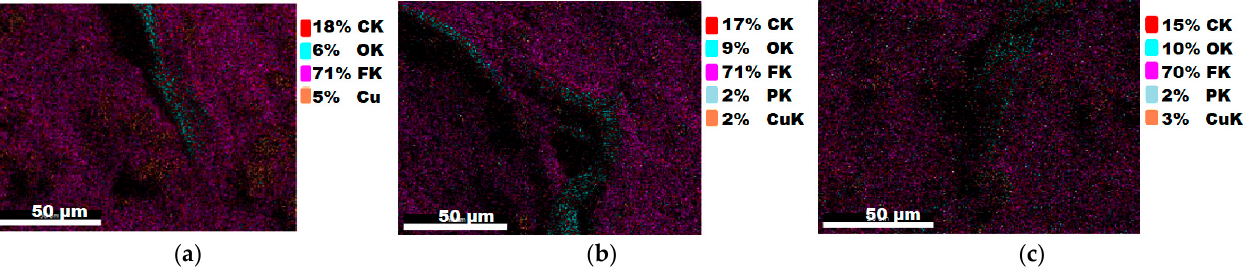
Figure 11. Smart elemental mapping overlay for sample 5: ( a ) untreated with artificial perspiration; ( b ) treated with acid perspiration; ( c ) treated with alkaline artificial perspiration.